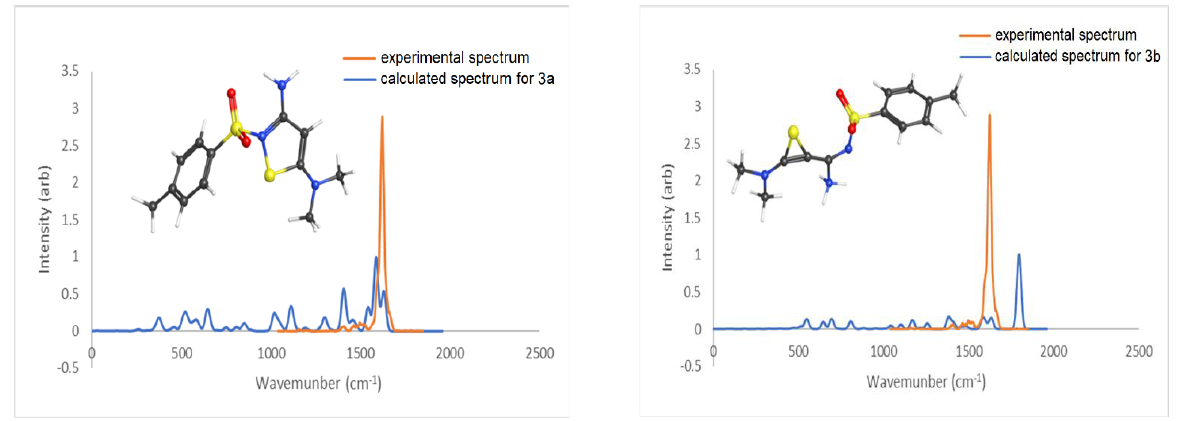
Figure 4. Calculated (blue trace) IR spectra (B3LYP/6-311+g(d,p)) for 3a (0.0 kJ/mol) and 3b (264 kJ/mol) vs. experimental (orange trace) IRMPD spectrum of the ion m / z 298. Another pair of isomeric structures may be proposed for the [M+H-N 2 -RSO 2 ] + ion of m/z 183 in the case of the piperidinyl derivative (Scheme 7). The first one, 4a , containing a five-membered thiazole ring and an amino group, was found to be 84.5 kJ/mol more stable than the 4b structure, which had a six-membered ring containing two nitrogen atoms and one sulfur atom.